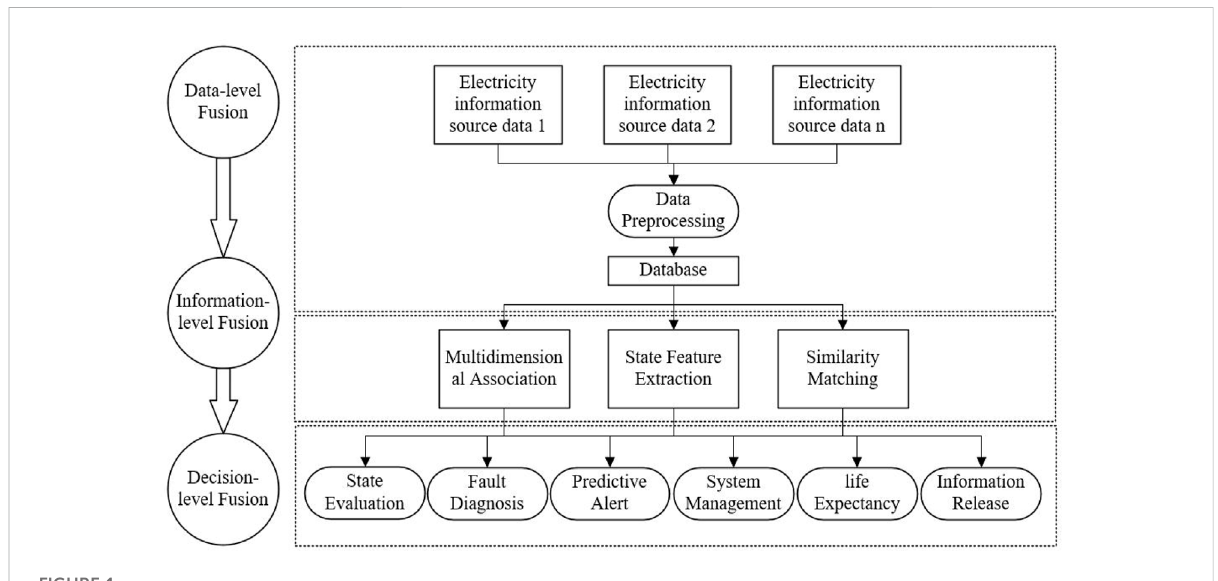
FIGURE 1 The fl ow chart of electric power information